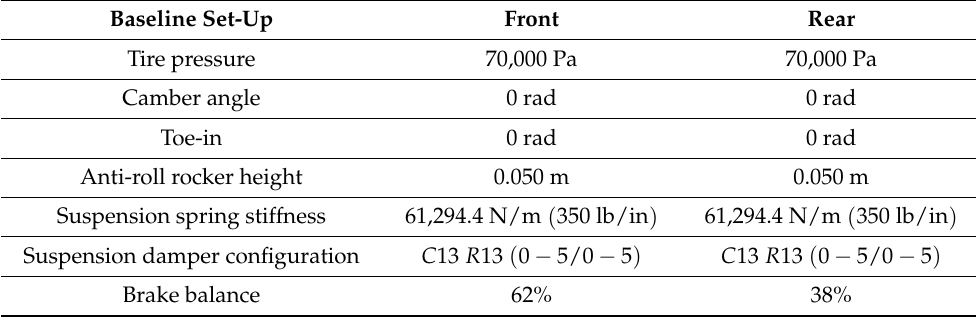
Table 2. Baseline configuration.